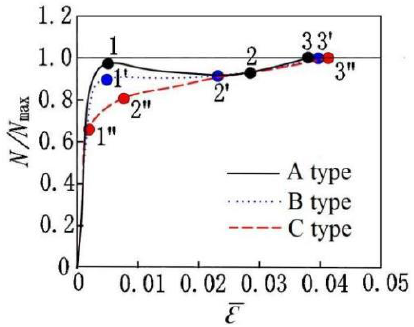
Figure 12. The three types of typical axial load (N) and average axial strain ( 𝜀̅ ) curves.